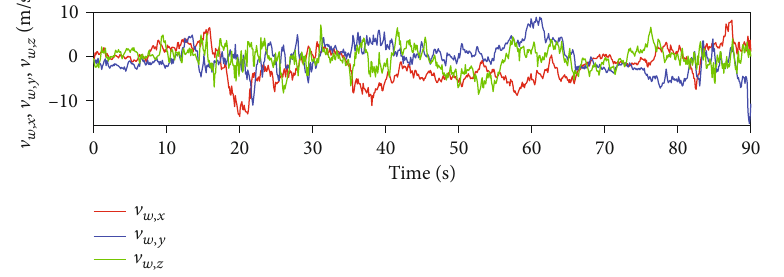
Figure 15: Velocities of the simulated Dryden